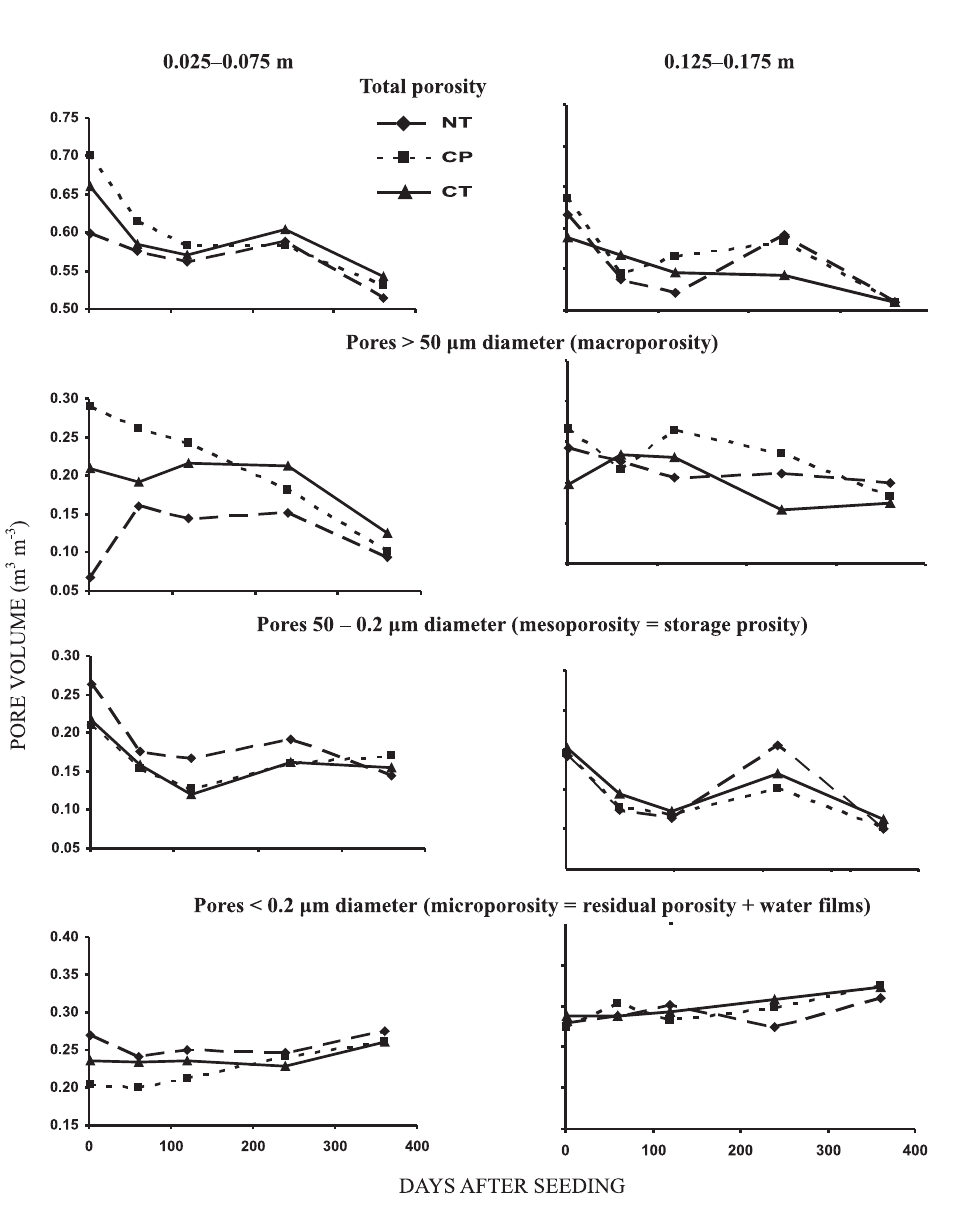
Figure 2. Changes in pore size distribution during the tenth year of no-till (NT), chisel plow (CP), and conventional tillage (CT)